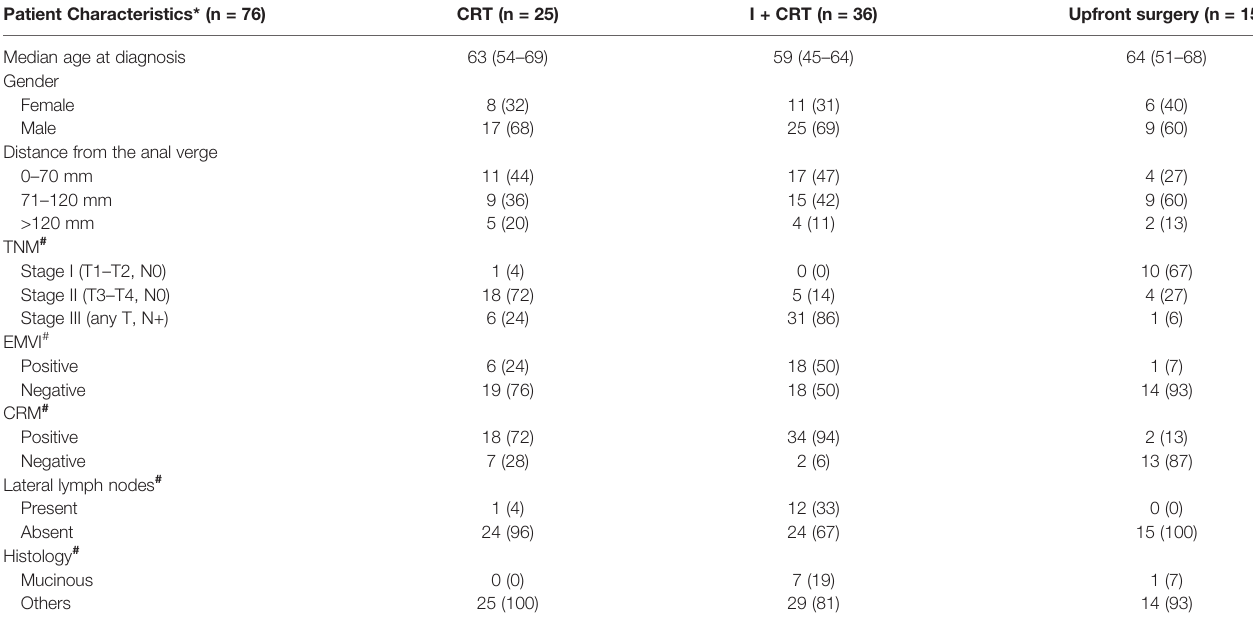
TABLE 1 | Clinical and demographics data of the non-metastatic rectal cancer cohort according to the treatment assigned. Patient Characteristics* (n =